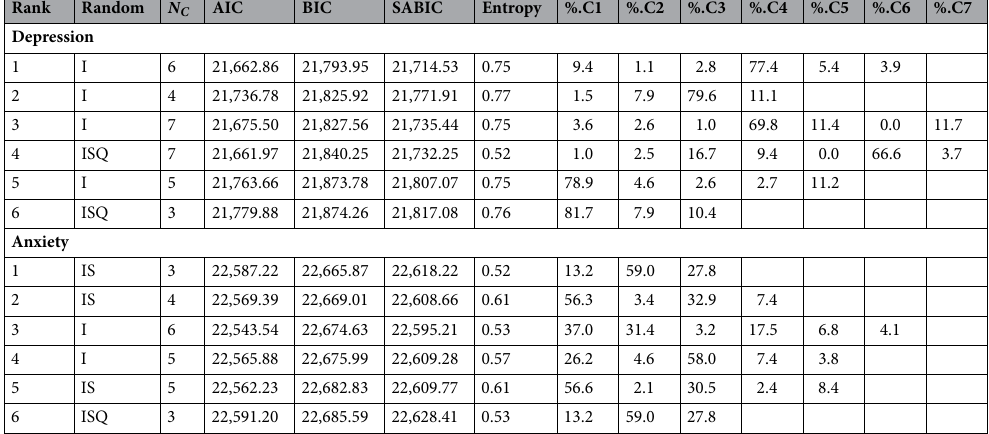
Table 3. Fit indices and class distributions of the six best growth mixture models for depression. The models are sorted by increasing BIC. The ‘Random’ column indicates the combination of random parameters in the model (‘I’ stands for intercept, ‘S’ for linear slope, and ‘Q’ for quadratic slope). The N C column gives the number of classes estimated in the model.